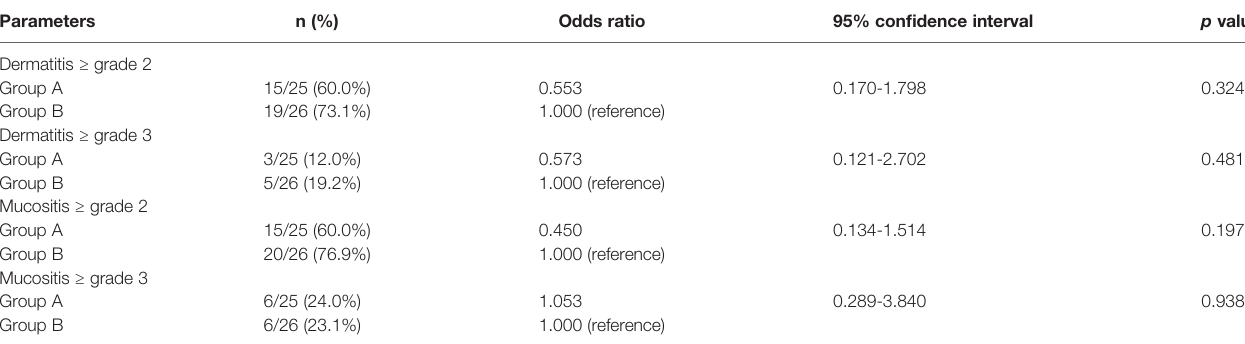
TABLE 4 | Comparison of acute dermatitis and mucositis in group A and B (Patient-based analyses). Parameters n